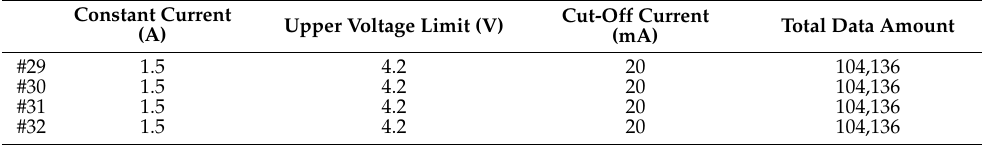
Table 1. Charging Conditions and Ratio of Used